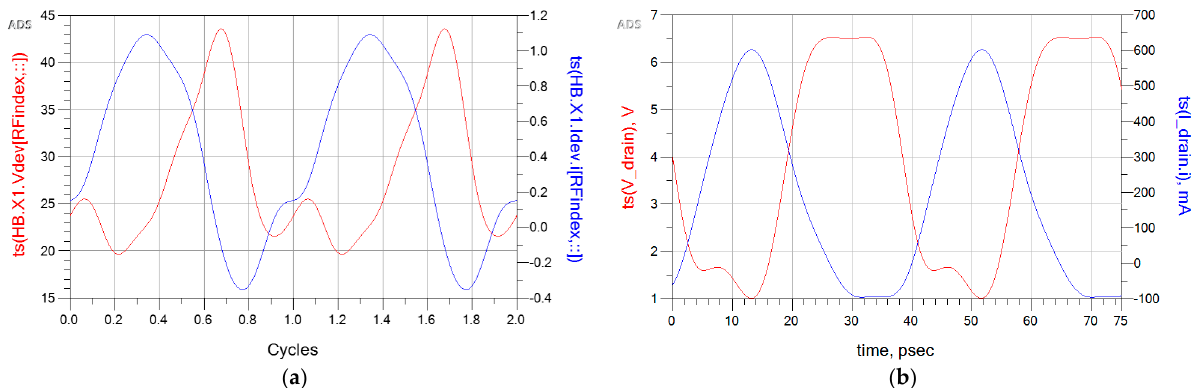
Figure 3. Time domain drain voltage (V) and drain current (I) waveforms of ( a ) the conventional Class-J PA and ( b ) the modified Class-J PA.